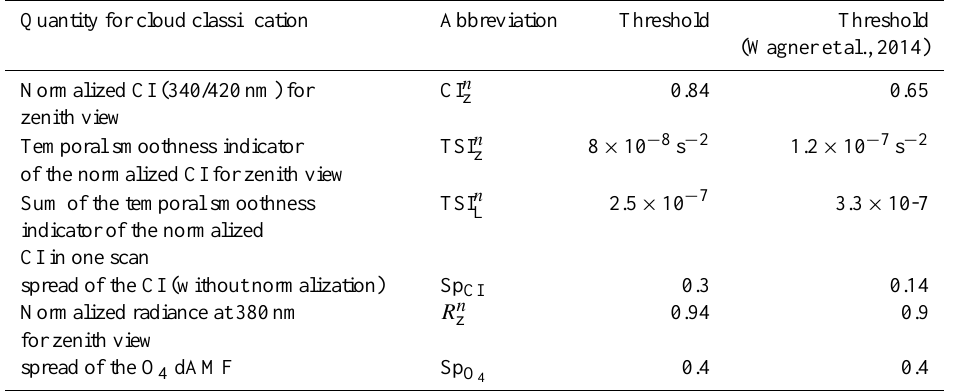
Table 1. Quantities derived from MAX-DOAS observations for cloud classification, their abbreviations and thresholds. The superscript n means normalized quantity. The subscripts z and L indicate zenith and off-zenith views, respectively.